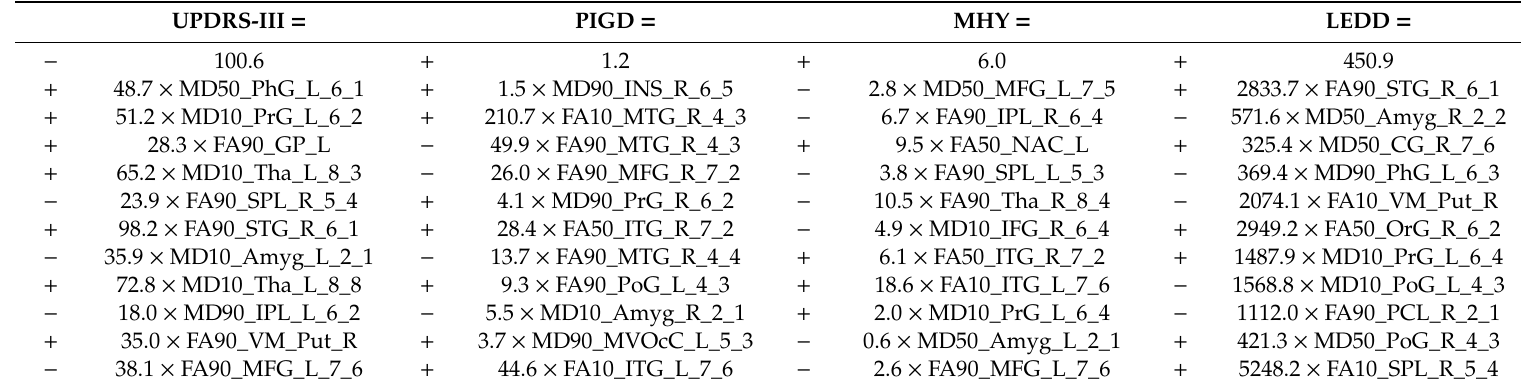
Table 2. Predictive variables in regression model for each